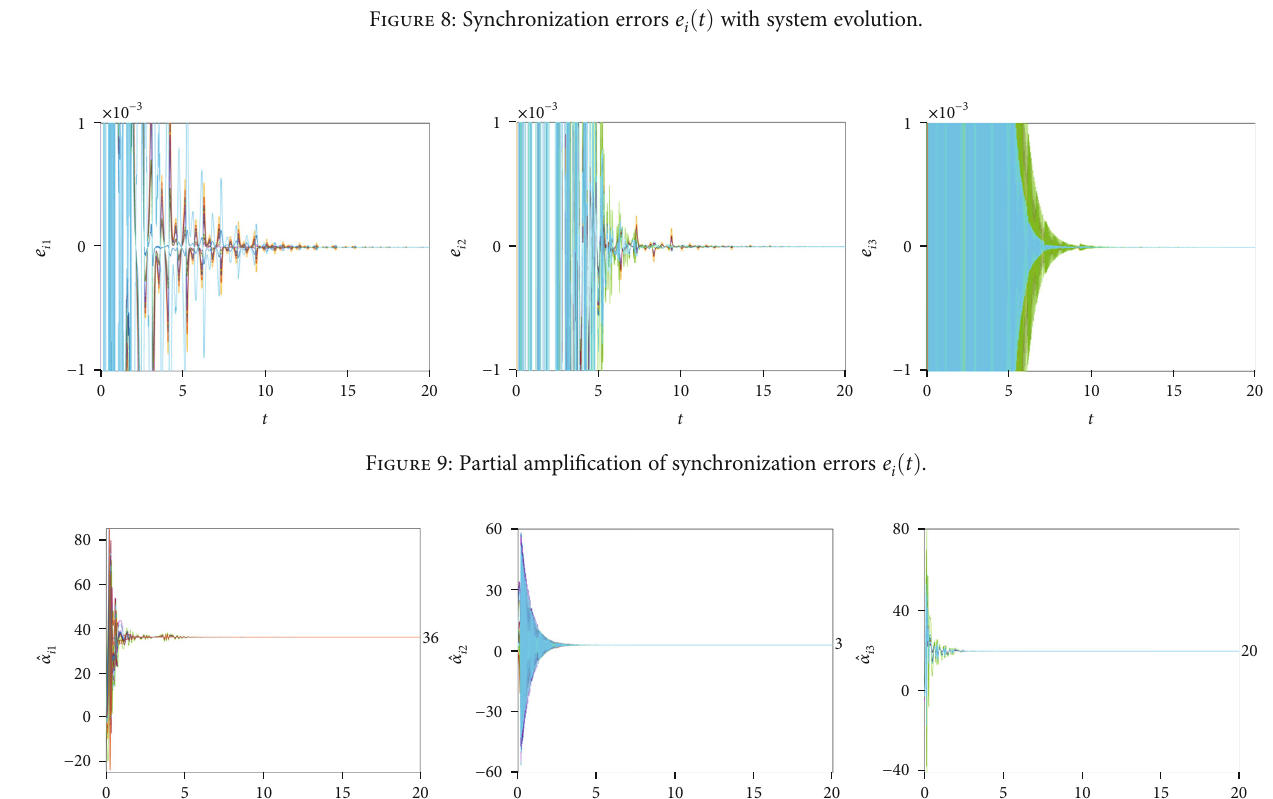
ð t Þ with system evolution. i